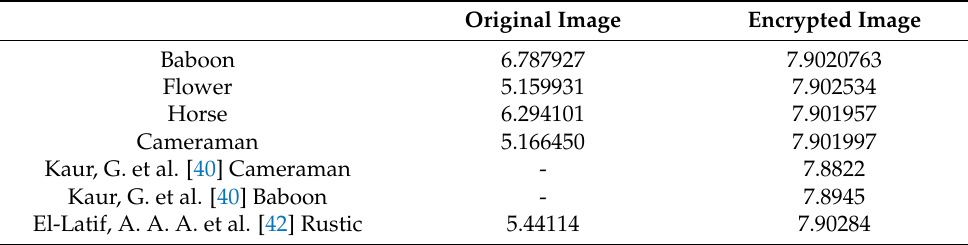
Table 8. Local entropy.